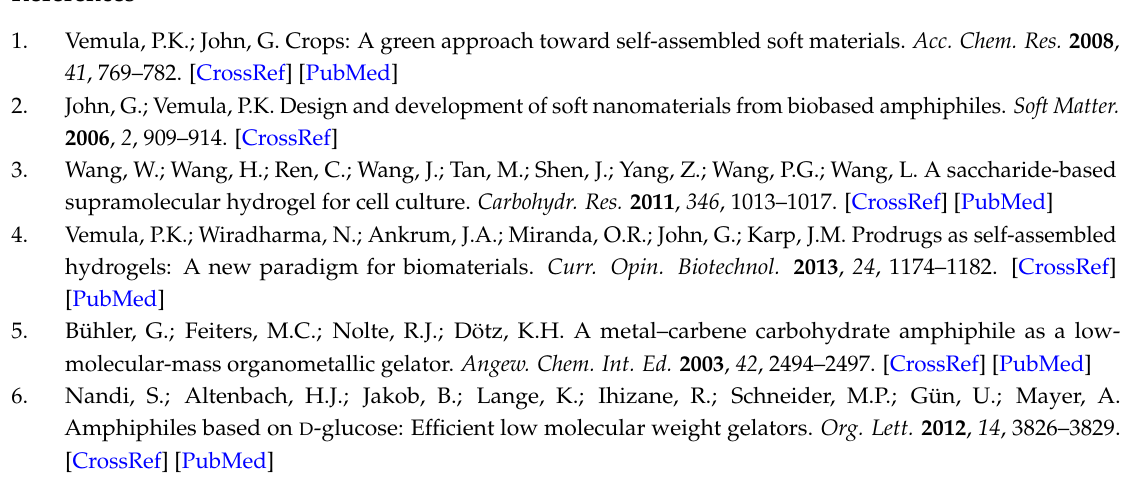
Figure S1. 1 H NMR spectrum of gluconohydrazide gelator. Figure S2. 1 H NMR spectrum of gluconosemicarbazide gelator. Figure S3. 13 C NMR spectrum of gluconosemicarbazide gelator in DMSO-d 6 . Table S1. Gelation properties of C 16 gelator [solvent:water = 80:20 ( v / v